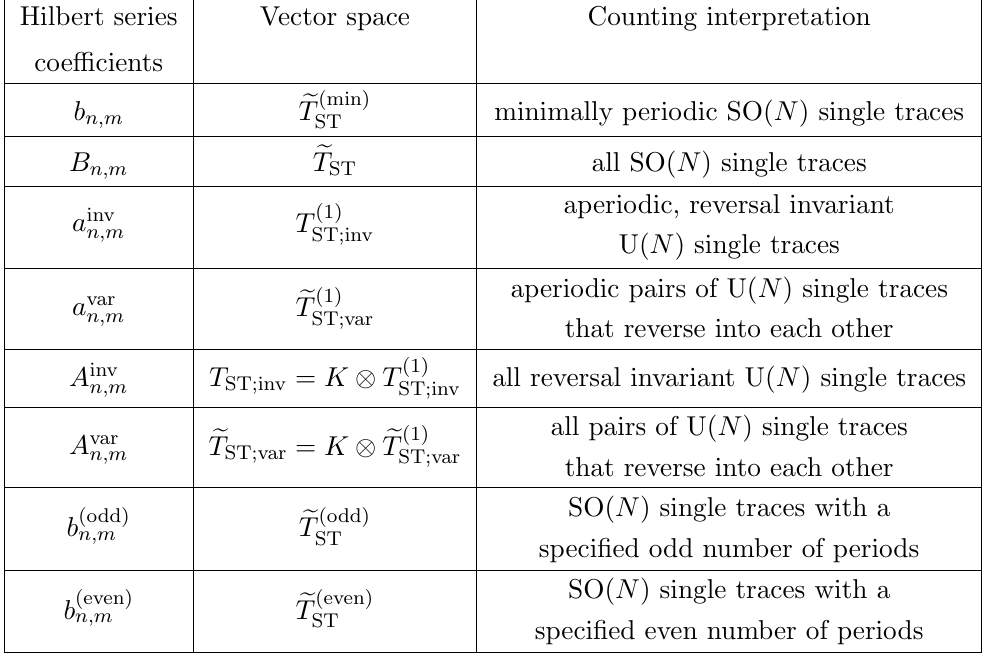
Table 4 . De(cid:12)nition of various single trace counting sequences. Formally, they are de(cid:12)ned as the coe(cid:14)cients of Hilbert series for certain vector spaces. We also give the counting